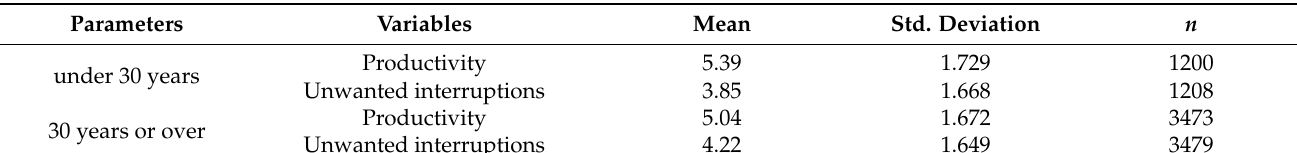
Table 10. Descriptive statistics of productivity and unwanted interruptions for under 30 years and 30 years or over.